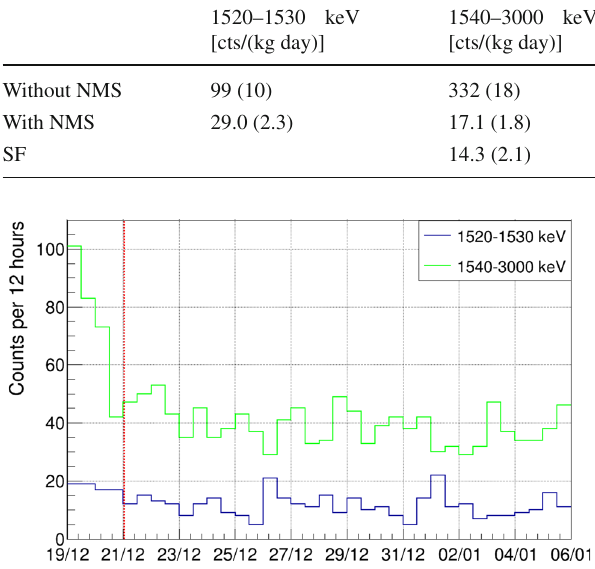
The energy spectra registered without and with NMS are scaledproportionallytothemeasurementtime.Table2shows